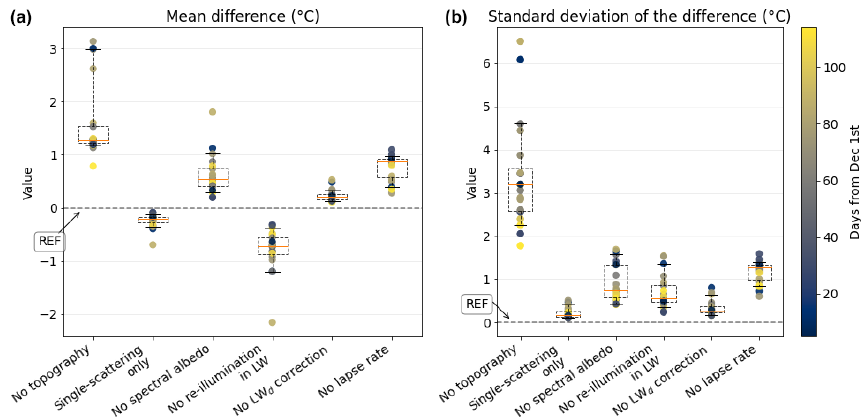
Figure 10. Overall representation of the mean difference and standard deviation between the reference simulation (REF), where all processes are considered, and the additional simulations, where one topographic effect is disabled at a time. The whiskers of the boxplots represent the 10th and 90th percentiles of the